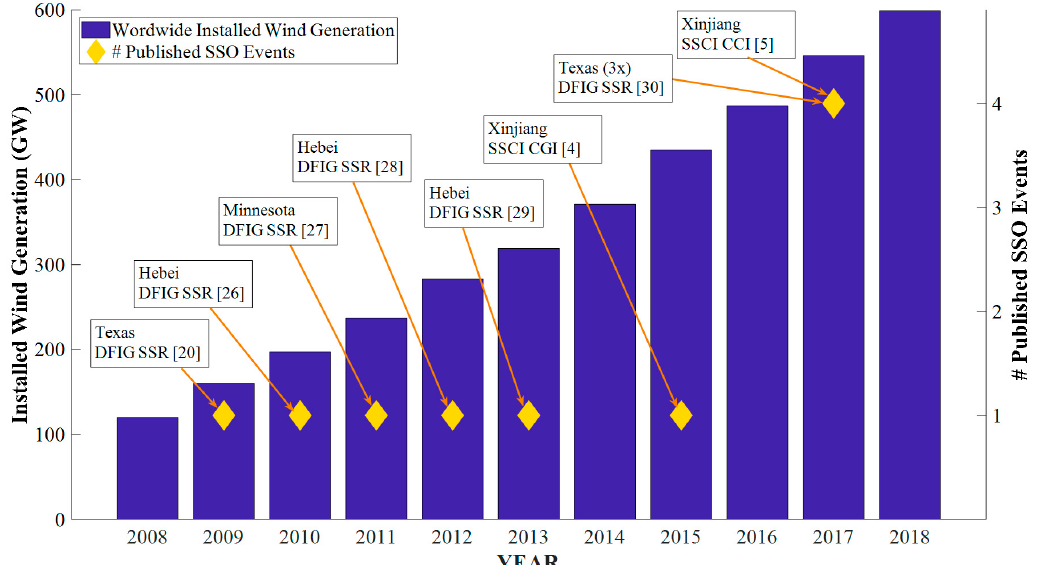
Figure 7. Overview of worldwide installed wind generation and the number of published SSO